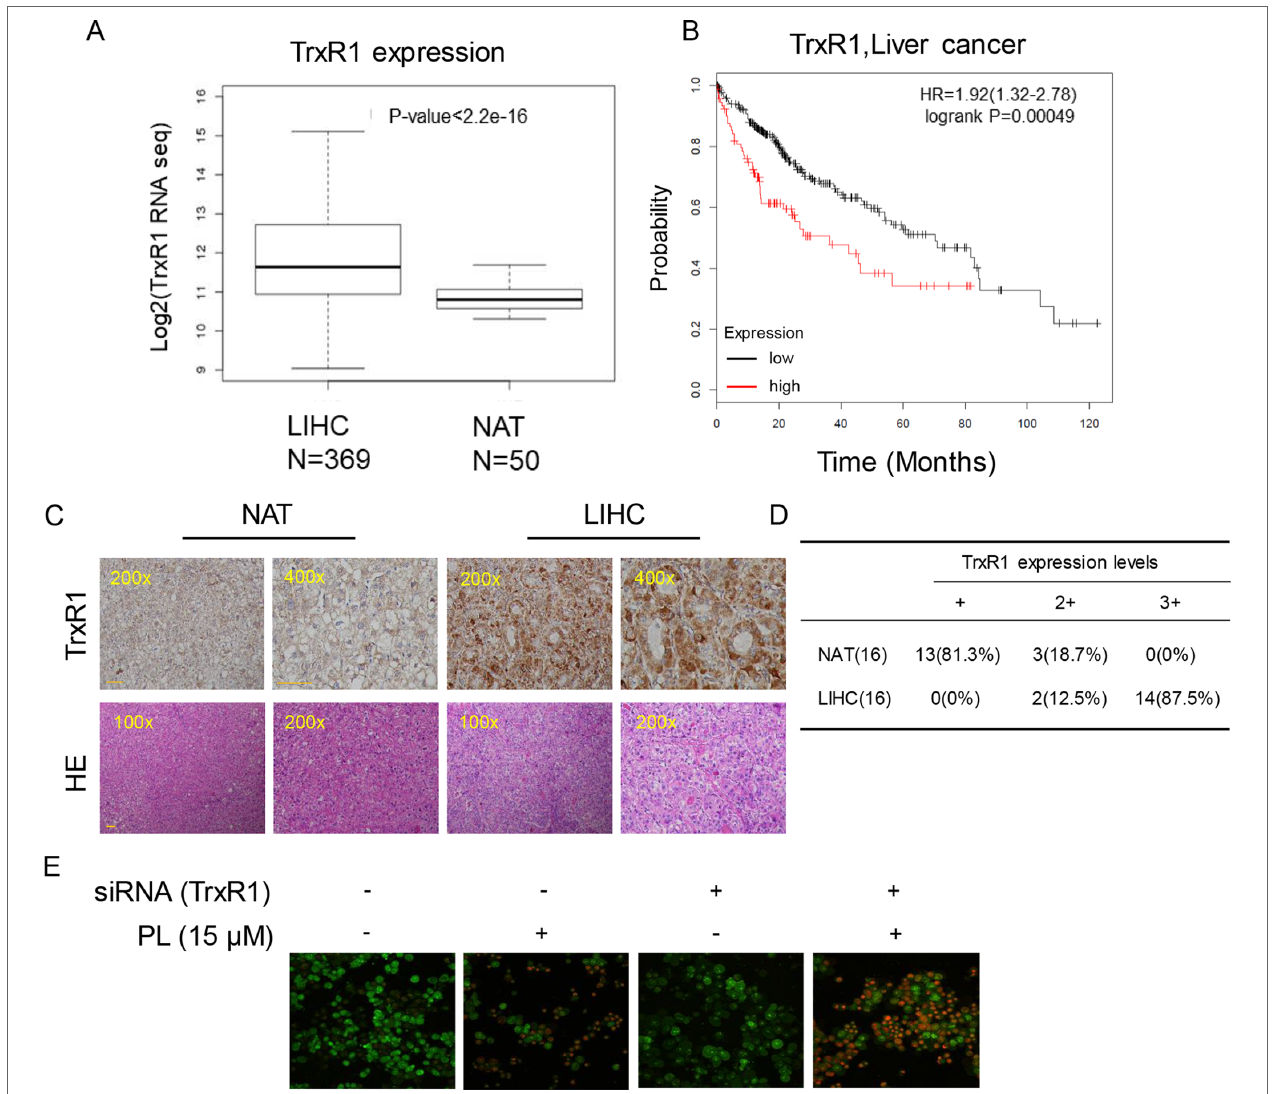
FIGURE 5 | Upregulation of TrxR1 expression in LIHC. (A) TrxR1 levels in LIHC liver hepatocellular carcinoma and NATs normal adjacent tissues. (B) Higher increased TrxR1 protein expression predicts decreased survival. (C) Representative immunohistochemical staining for TrxR1 in LIHC and NATs. Bar, 100 µm. (D) Summary of immunohistochemical staining results. (E) HUH-7 cells transfected with TrxR1 siRNA and treated with 15 µM PL. Apoptotic cells were determined by acridine orange and ethidium bromide dual staining. Three independent experiments were